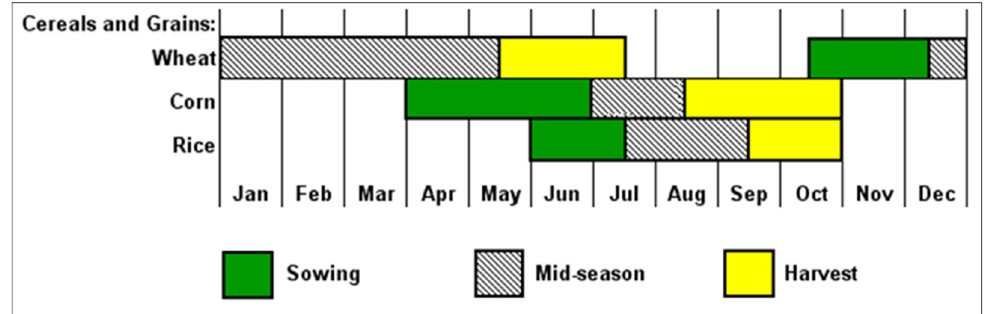
Figure 3. Crop calendars of selected crops in Afghanistan.